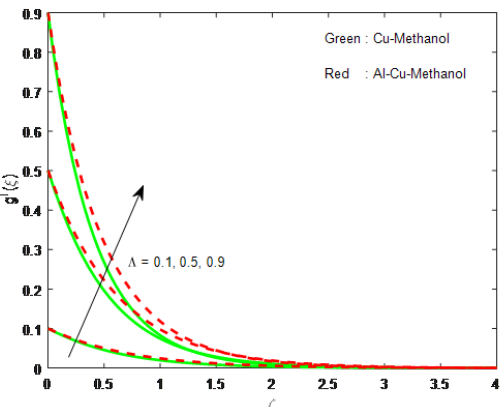
Fig. 12: Impression of Λ on g (cid:48) ( ξ )